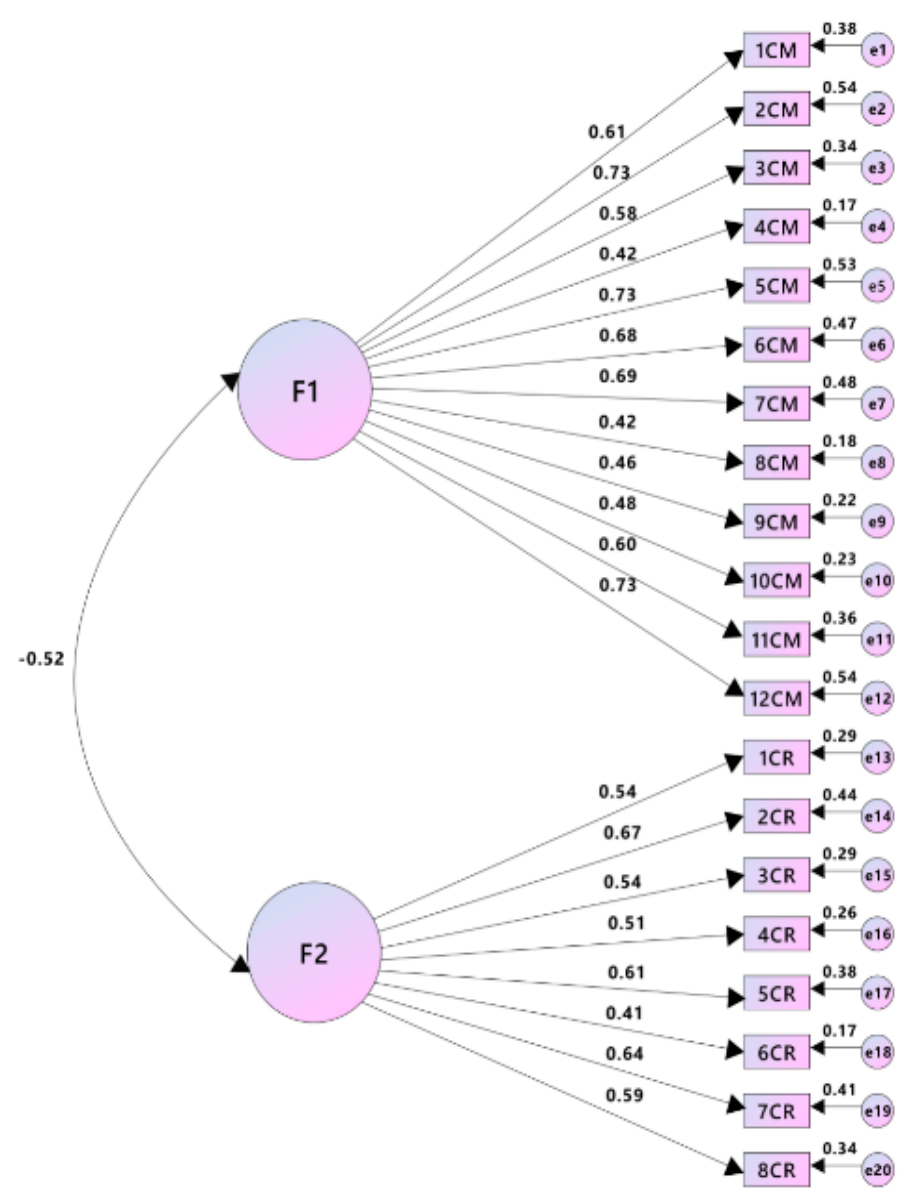
Figure 1. Measurement model of the Institutional Identity Scale for University Students.